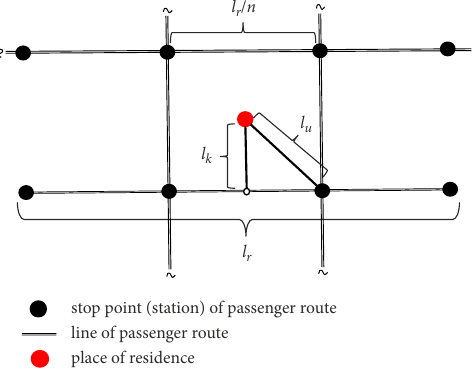
Figure 1. The scheme definition of walk distance from the place of residence to the nearest